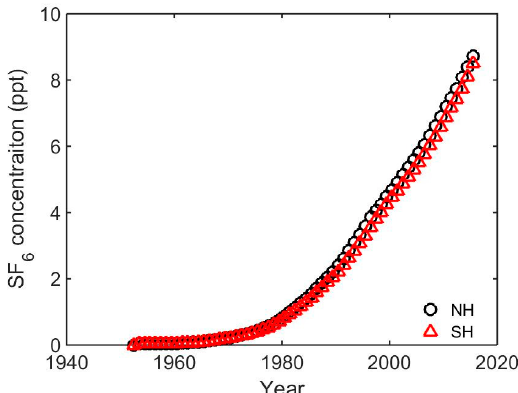
Figure 1. Mean mid-year tropospheric SF 6 concentrations in the northern (NH) and southern (SH) hemispheres for the period 1952.5 to 2015.5 [6].